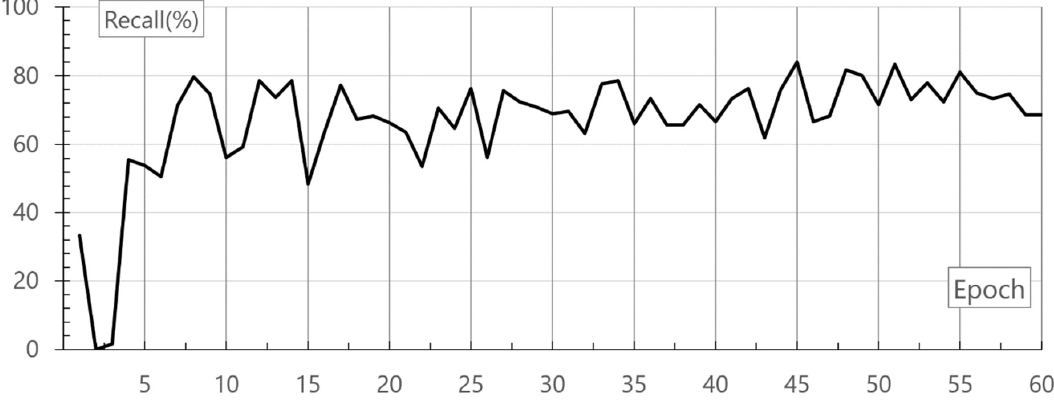
Figure 9. Result of recall evaluation.